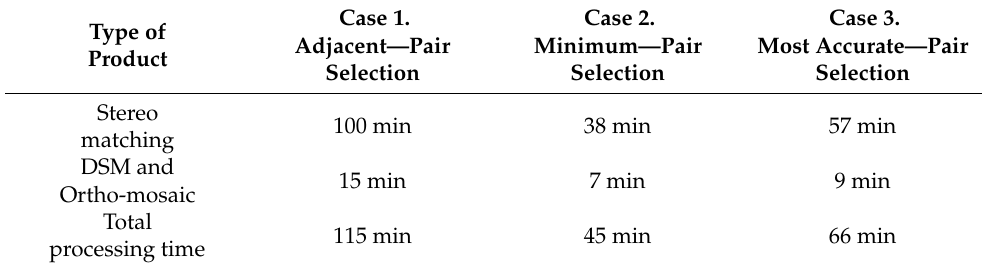
Table 4. Resulting processing times for all types of pair